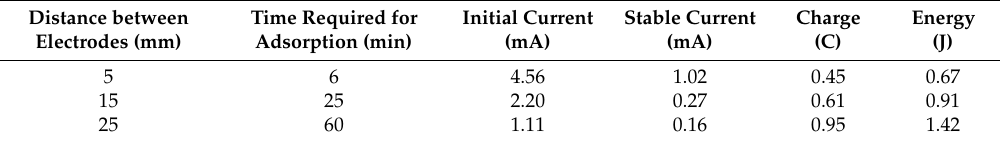
Table 2. The current of the CDI system for different inter-electrode distances using 1.5 V.